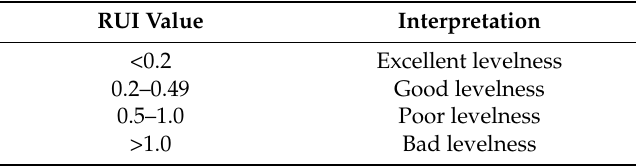
Table 4. Interpretation of the relative unlevelness index (RUI)